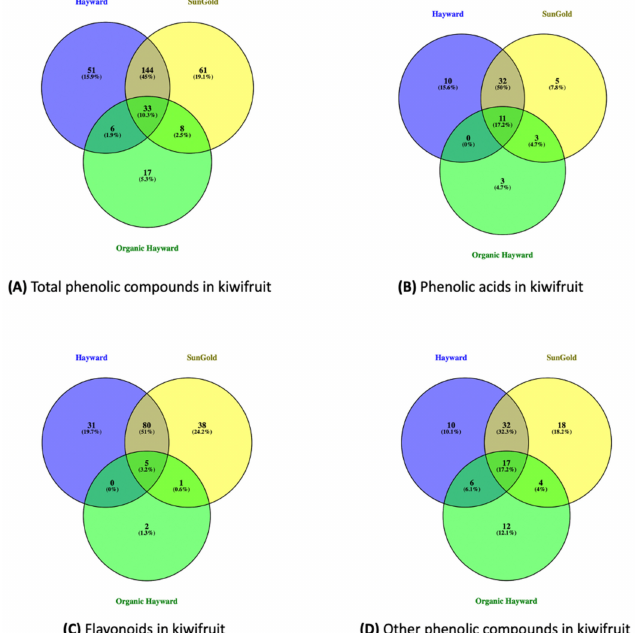
Figure 1. Venn diagram of phenolic compounds present in kiwifruit samples. The similarity of total phenolic compounds ( A ) , phenolic acids ( B ), flavonoids ( C ), and other phenolic compounds ( D ) profiles between the three kiwifruit